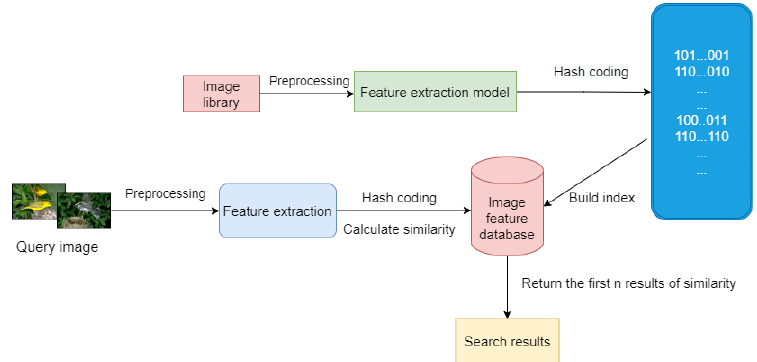
Figure 1. Flow chart of the image retrieval